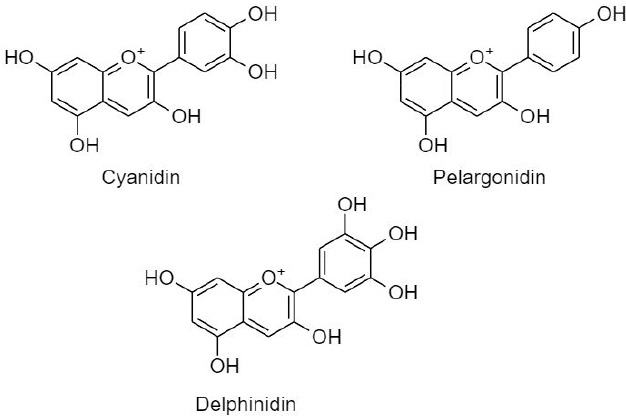
Figure 10. Classification and structures of anthocyanidins.